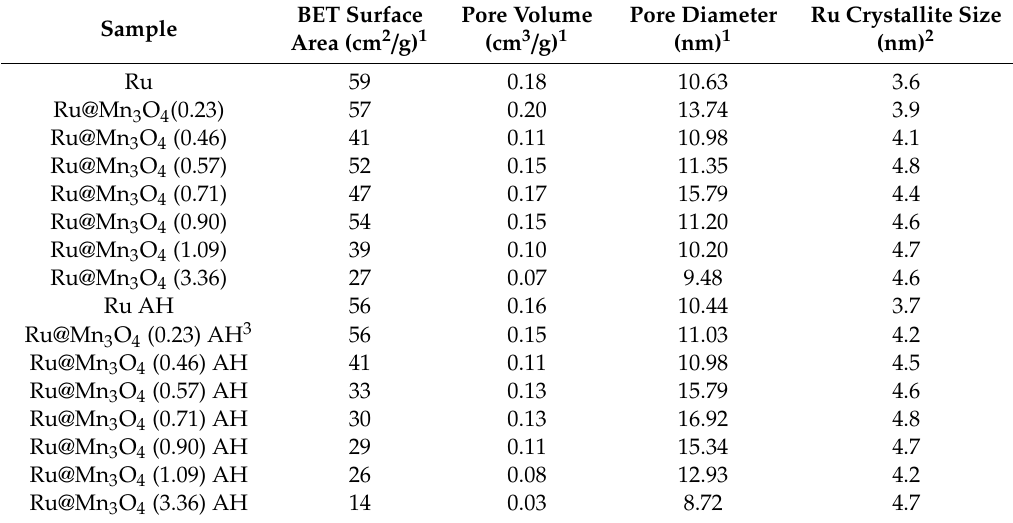
Table 1. Texture properties and crystallite size of monometallic Ru as well as Ru@Mn 3 O 4 ( x ) before and after catalytic experiments. BET Surface Sample Area (cm 2 / g)